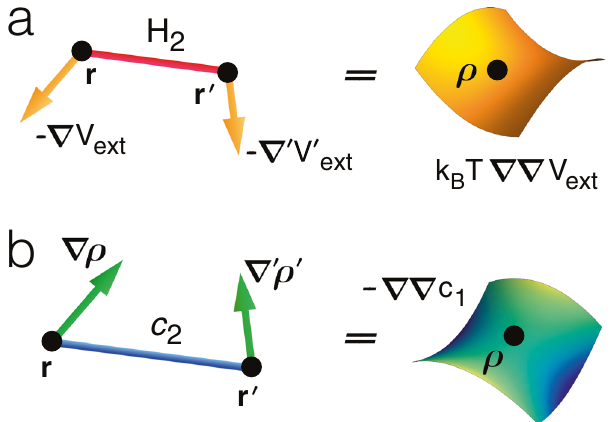
Fig. 1 Illustrations of the sum rules for the variance of fl uctuations. The sum rules arise from Noether invariance against spatial displacement. Shown are the different types of identical integrals. Thick dots indicate position variables that are integrated over. a External sum rule, Eq. (4), which relates the correlation function of density fl uctuations H 2 ð r ; r 0 Þ and the external force fi eld − ∇ V ext ( r ) with the product of the density pro fi le ρ ( r ) and the Hessian of the external potential k T ∇ ∇ V B ext ( r ). This curvature is indicated by a schematic heat map. b Internal sum rule, Eq. (8), where the density gradient at two different positions is bonded by the direct correlation function c 2 ð r ; r 0 Þ . This integral is identical to the integrated Hessian − ∇ ∇ c 1 ( r ) (indicated by a schematic heat map) weighted by the local density ρ ( r